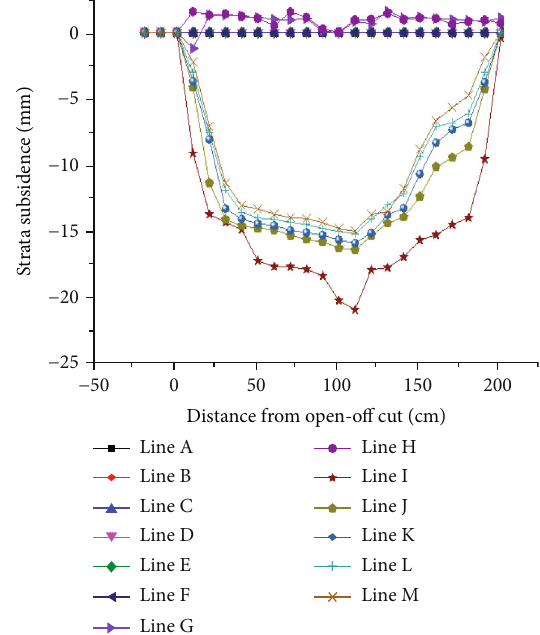
Figure 14: Displacement curves when the working face is pushed 200m.